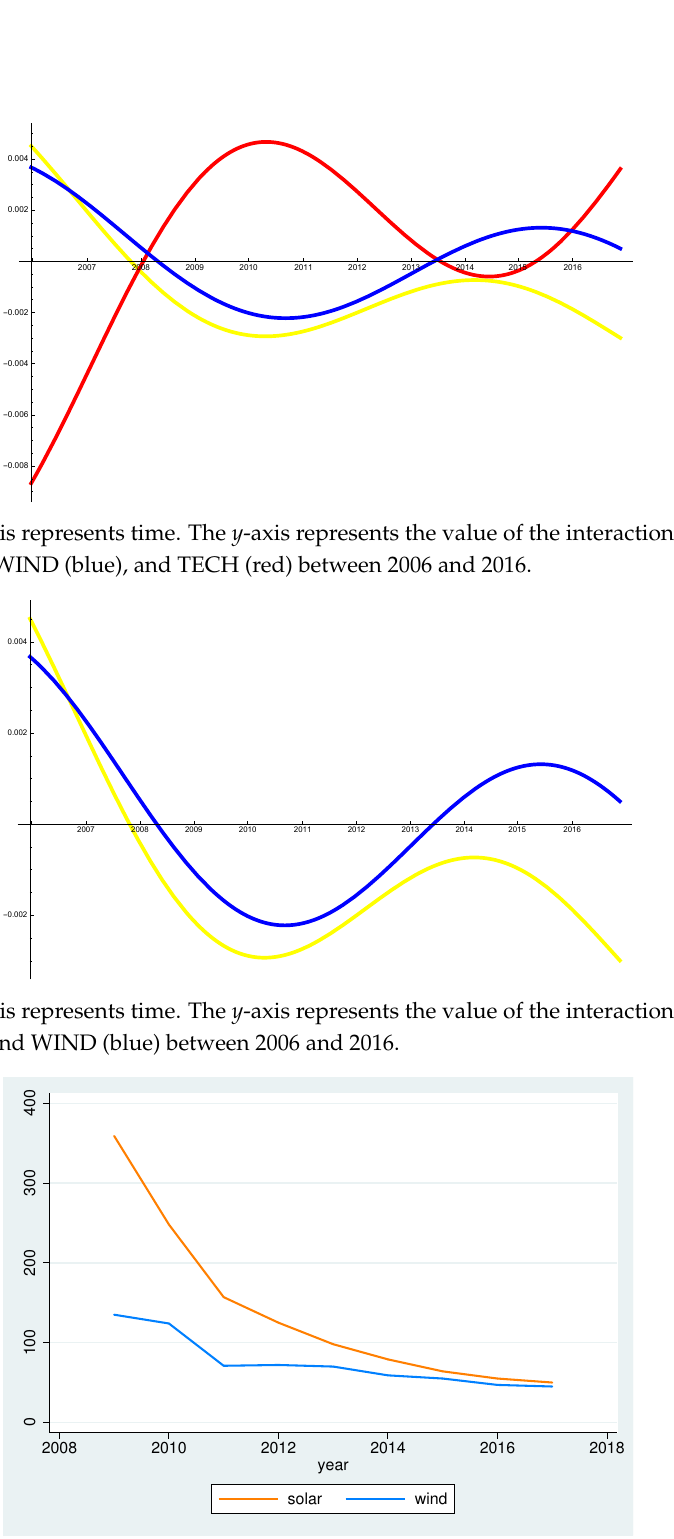
Figure 8. Historical mean levelized cost of energy for WIND and SOLAR between 2009 and